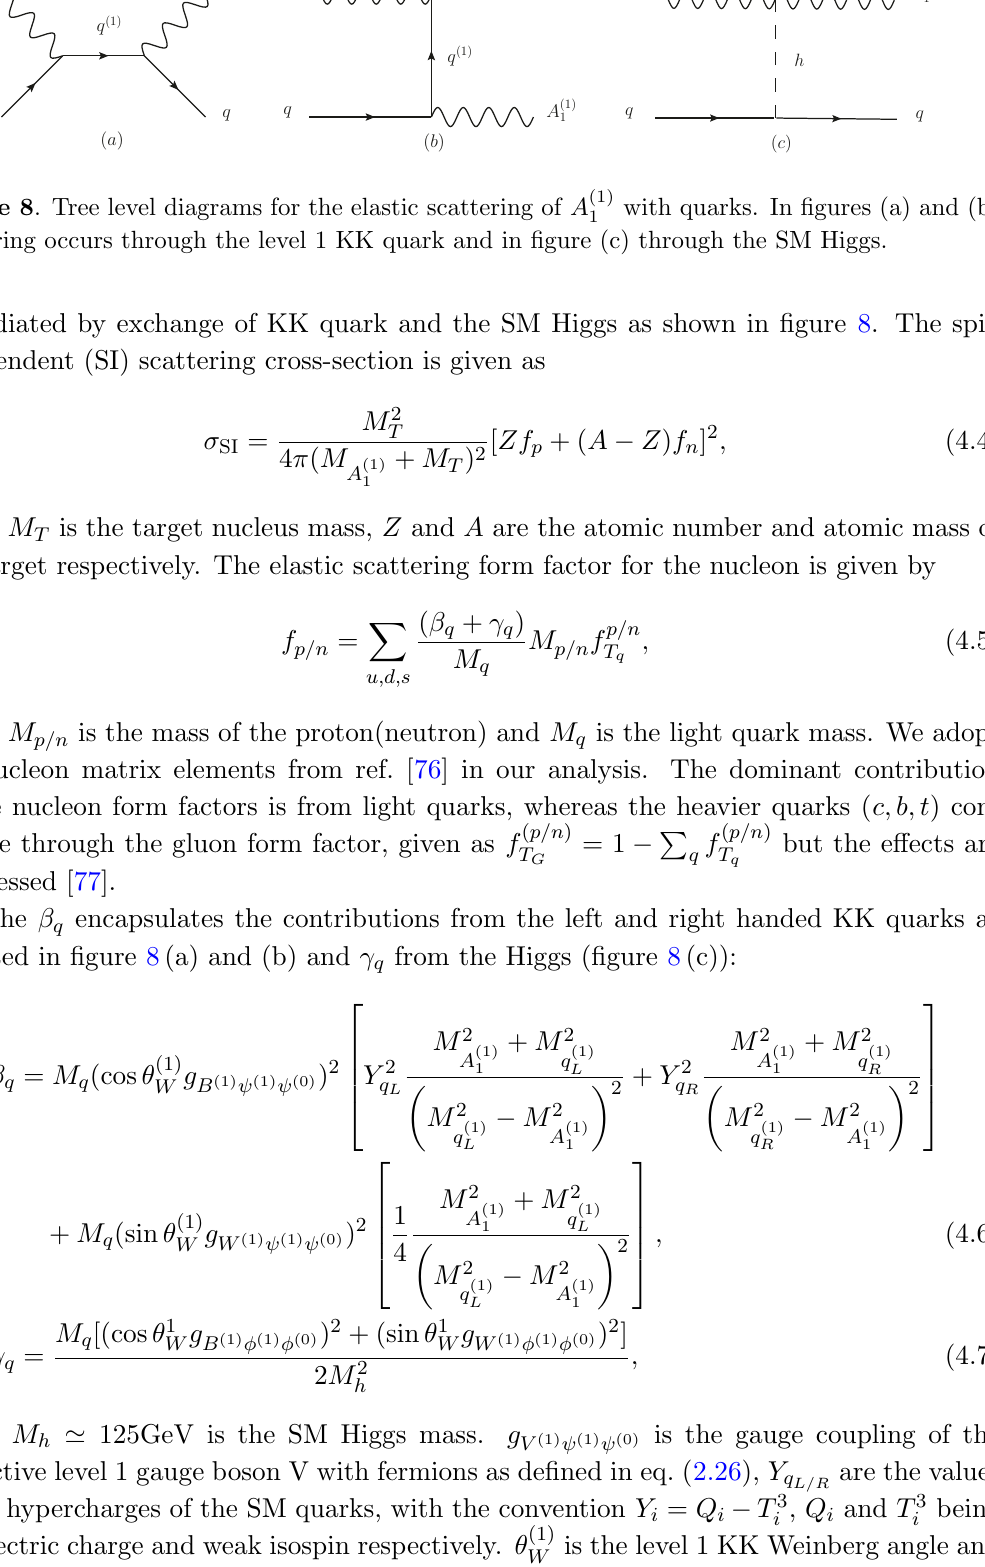
with quarks. In (cid:12)gures (a) and (b) 1